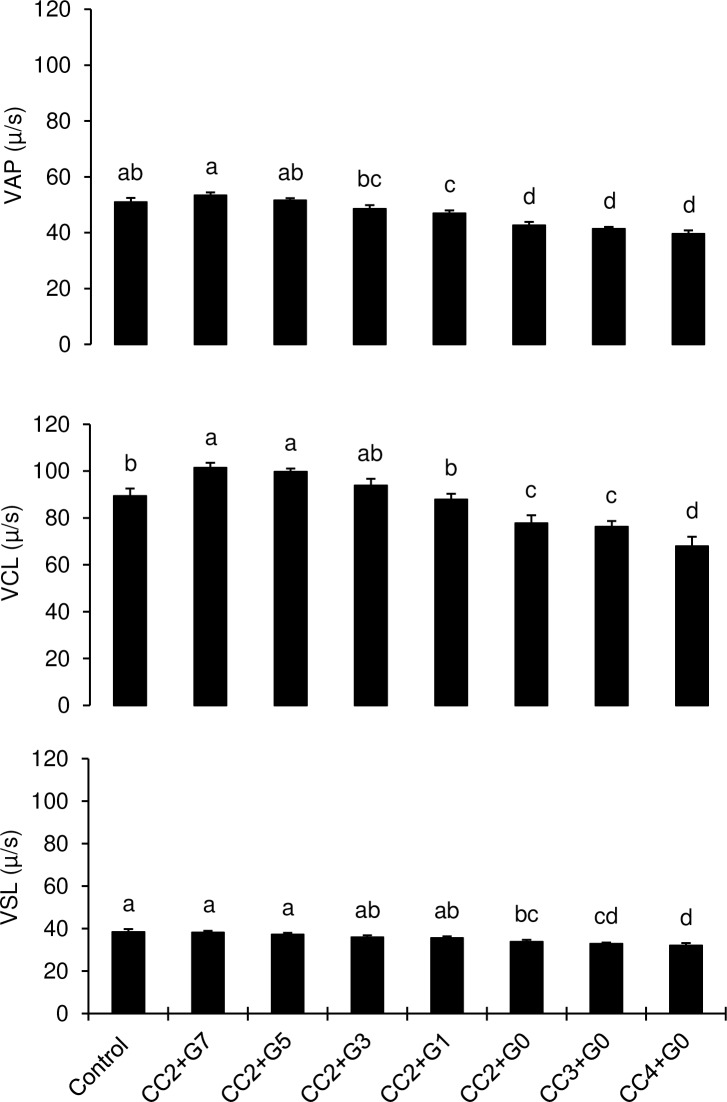
Effect of different concentrations of cholesterol-cyclodextrin complex and glycerol on post-thaw sperm average path velocity (VAP), curvilinear velocity (VCL) and straight-line velocity (VSL).Each bar represents mean±SEM of five pooled ejaculates (replicates) from four bulls. Bars with different letters (a-d) within a sperm motility characteristic differ from each other. Number (2, 3 or 4) following letters CC represents concentration of cholesterol-cyclodextrin complex (mg/ml). Numbers (7, 5, 3, 1 or 0) following letter G represent glycerol concentration in CC+TG extender.